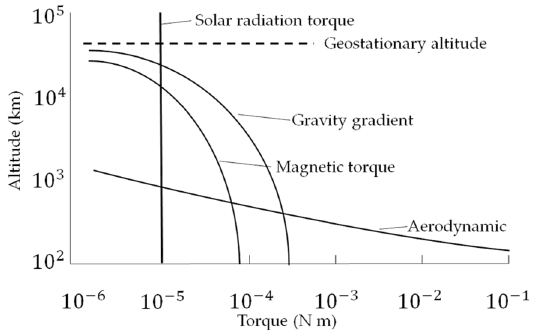
Figure 2. Rough order-of-magnitude of environmental torques available to spacecraft as a function of altitude. These environmental torques may be used for angular momentum modification, and this manuscript focuses on such modification using only magnetic torques.